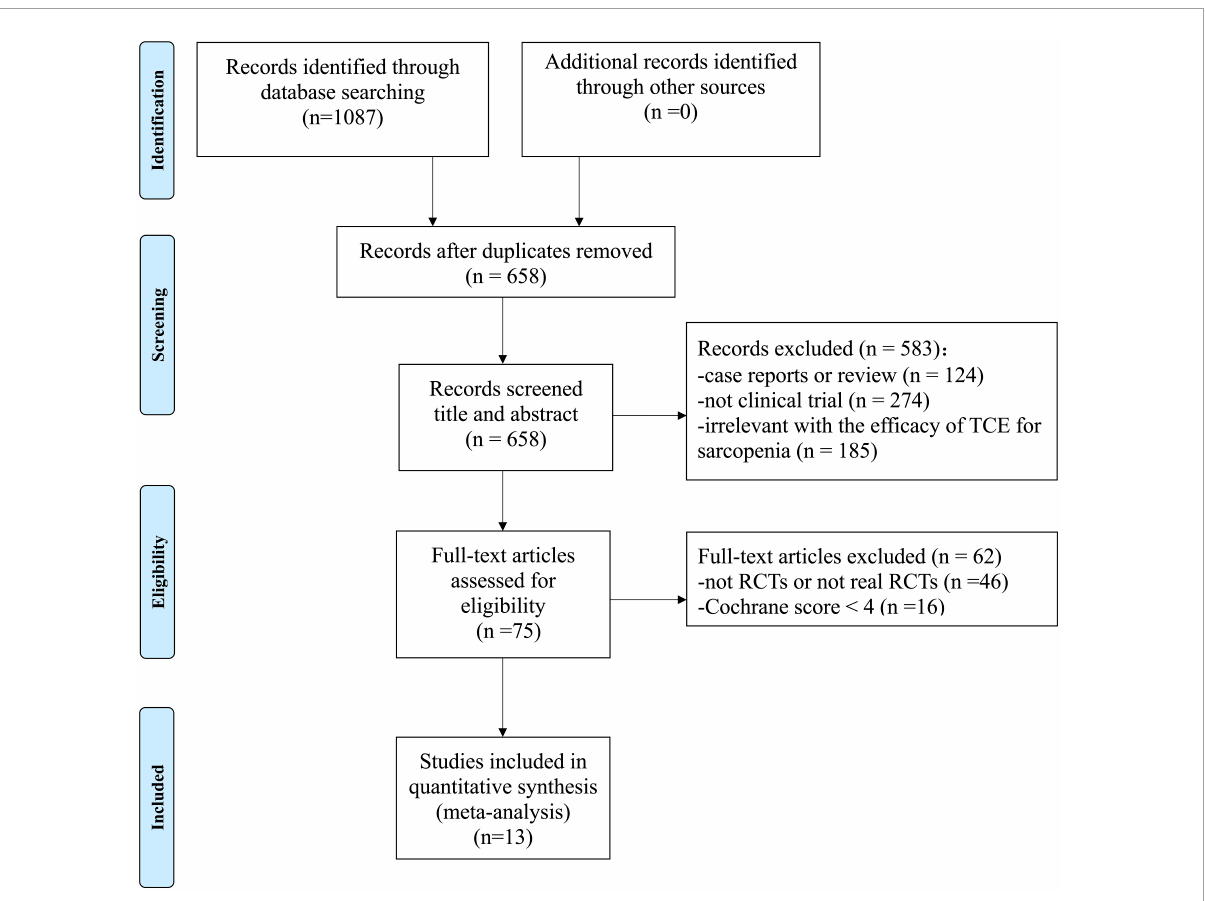
FIGURE1 PRISMA 2009 flow